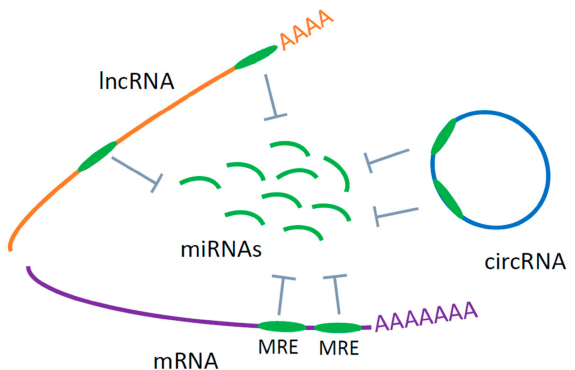
Figure 1. Competitive endogenous RNA (ceRNA) hypothesis: MicroRNAs (miRNAs) are commonly considered as active negative regulators of gene expression, decreasing the stability of target mRNAs or limiting their translation. miRNAs act through specific complementary binding of its seed region (usually 6–8 nt long) to the 3 (cid:48) untranslated region (UTR) of target mRNA, called miRNA response elements (MRE). However, recent studies have shown that the interaction with mRNA is not unidirectional, but that also other endogenous RNAs, like lncRNAs, and circRNAs possessing the same MRE sequence (shown in the figure) can compete for the same pool of miRNA thereby regulating miRNA activity [23]. (green oval represents miRNA response elements